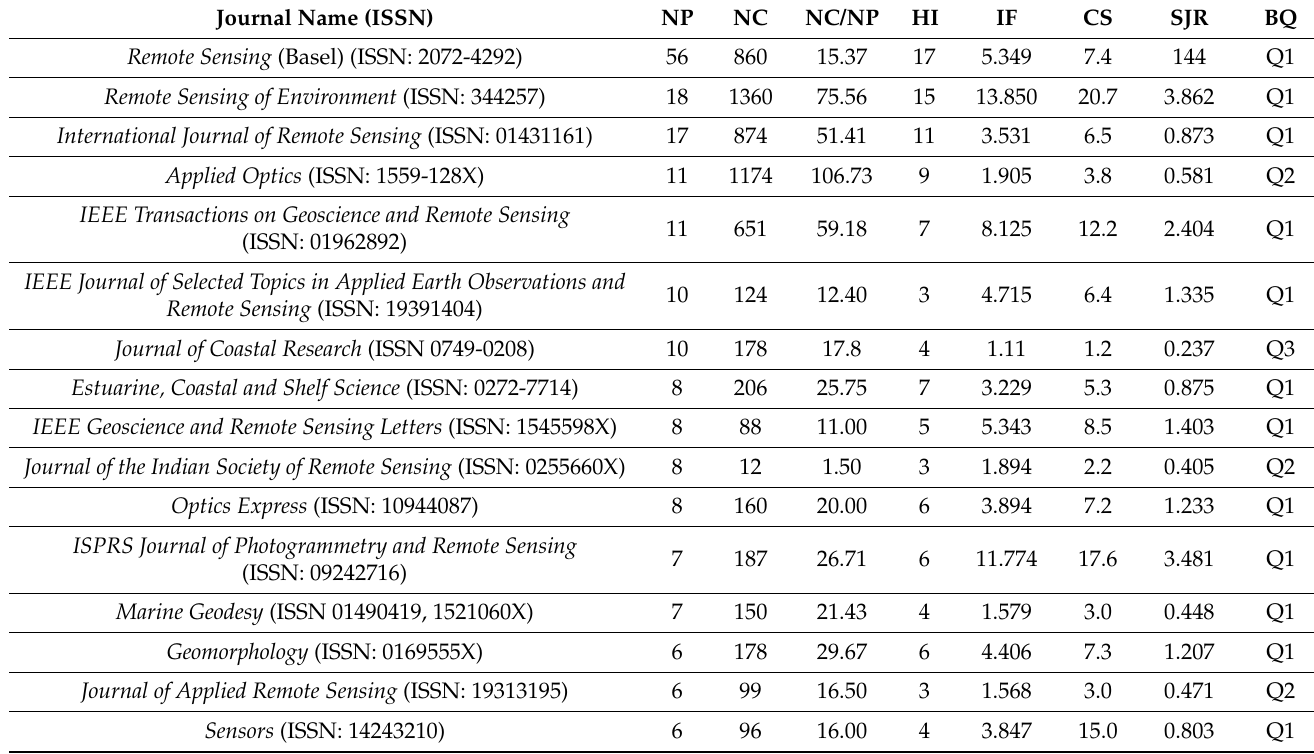
Table 3. Top 16 journals for SDB (according to